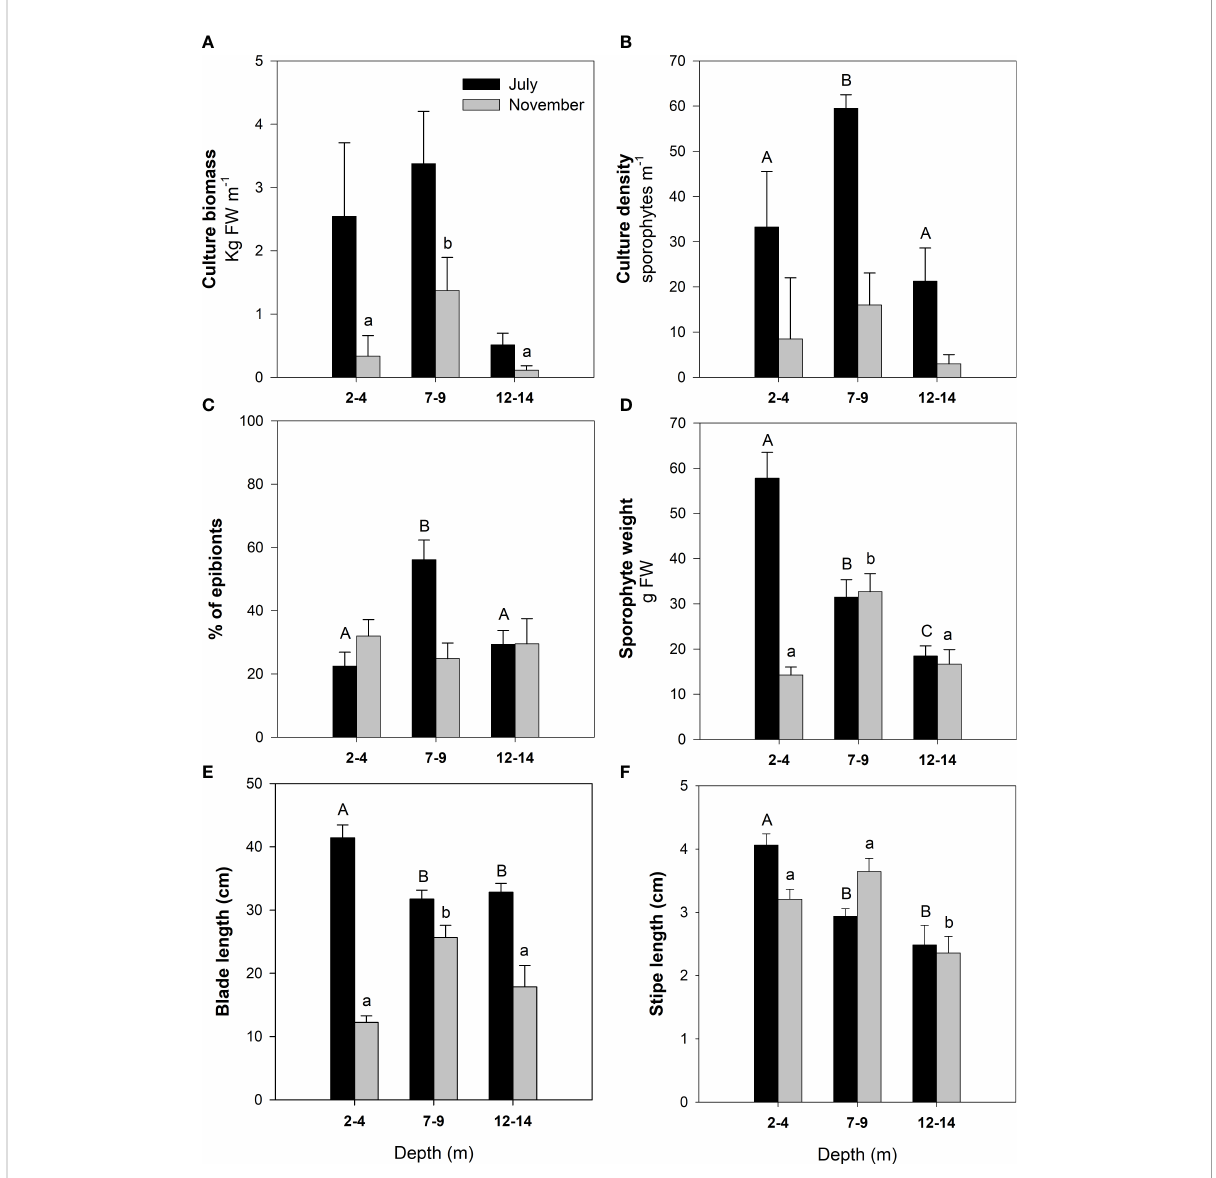
FIGURE 5 Biological descriptors (means and standard errors) measured at two sampling times (July and November 2016) in Eisenia arborea cultivated at three different depth ranges (2 – 4, 7 – 9, and 12 – 14 m). (A) Culture biomass, (B) culture density, (C) fresh weight of epiboints expressed as the percent of the total fresh weight of sporophytes, (D) sporophyte weight, (E) blade length, and (F) stipe length. Data correspond to the winter culture (i.e., seeding in February 2016). Different uppercase and lowercase letters indicate statistically signi fi cant differences (one-way ANOVA, post hoc Student Newman Keuls) among variables obtained at different depths in July and November,